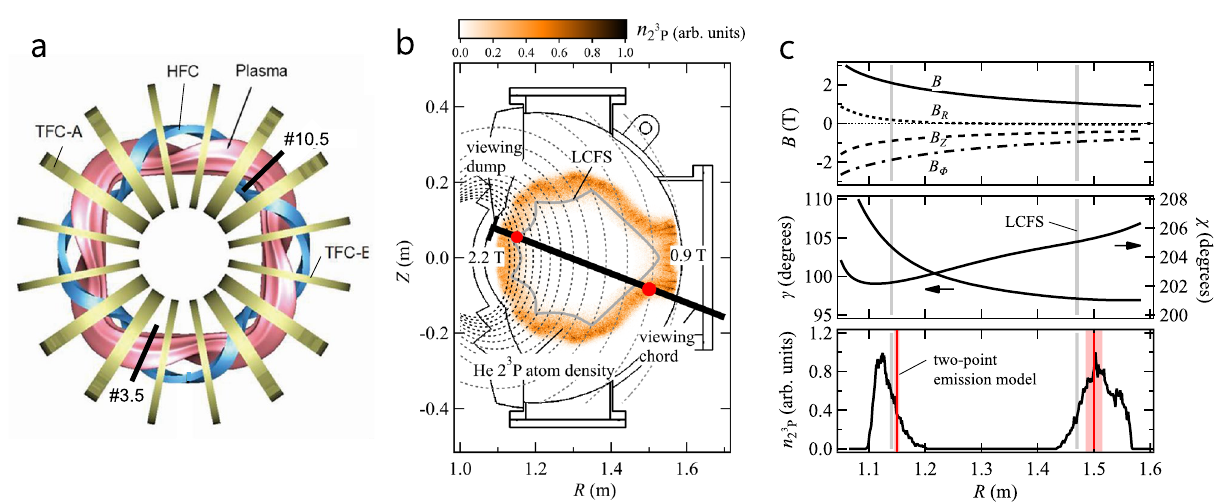
Figure 2. ( a ) Top view of Heliotron J with a helical field coil (HFC) and toroidal field coils (TFC-A and TFC- E). ( b ) #10.5 poloidal plane and viewing chord. The magnetic field strength of 0.9–2.2 T is shown with dashed lines. The relative 2 3 P excited helium atom density n 2 3 P obtained by simulation is shown with the color map and the emission locations and relative intensities determined using the two-point emission model are plotted with red circles. ( c ) Spatial profiles of magnetic field, γ , χ , and n 2 3 P (bin size is different from that of b ) along the viewing chord. The grey lines show the locations of the LCFS and the red lines show the emission locations determined using the two-point emission